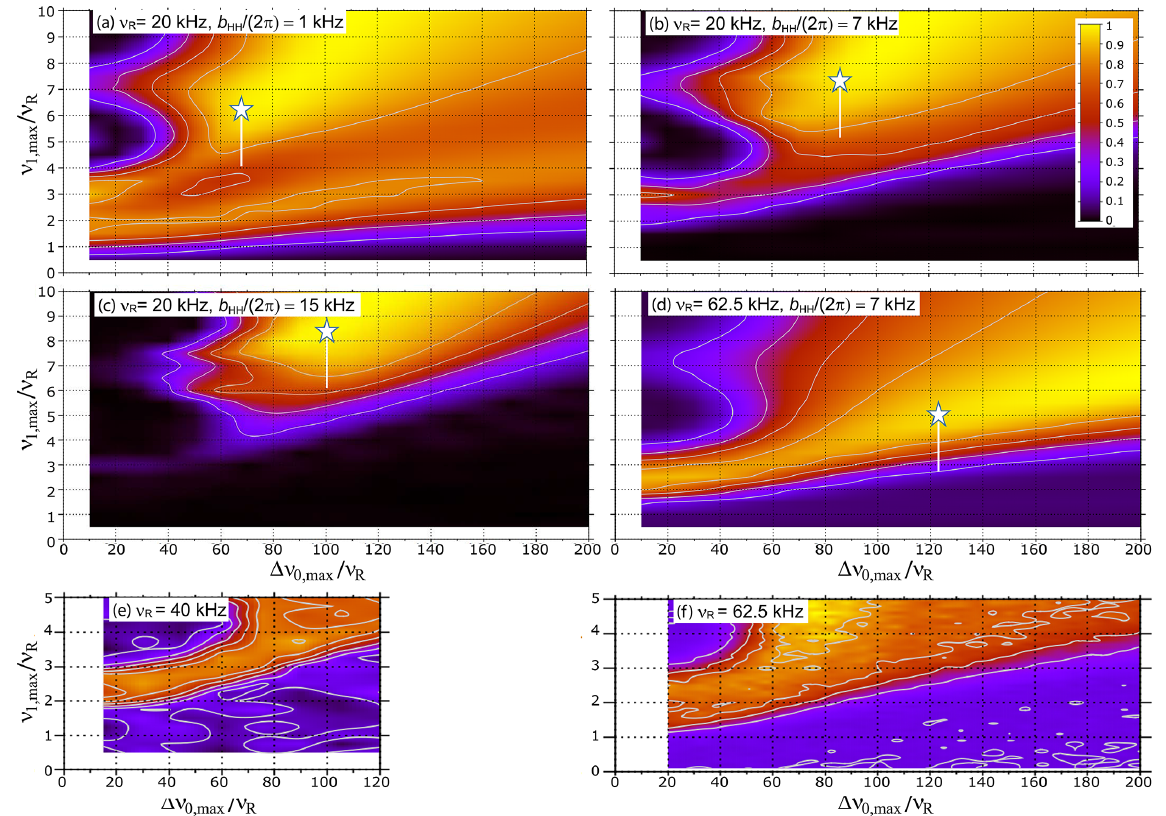
(tt) sequence for a 15 N 1 H 4 spin system as a function of Figure 2. (a–d) Simulated transfer efficiency of 1 H → 15 N D -RINEPT-SR4 2 1 ν 1 , max /ν R and (cid:49)ν 0 , max /ν R for ν R = 20 and 62.5kHz and b HH / ( π ) = (a) 1kHz, (b, d) 7kHz and (c) 15kHz. (e, f) Experimental 1 H → 15 N D -RINEPT-SR4 2 (tt) signal of L-histidine · HCl as a function of ν 1 , max /ν R and (cid:49)ν 0 , max /ν R at 18.8T with ν R = (e) 40kHz or (f) 62.5kHz. 1 In panels (a) – (d) the white star indicates recoupling conditions with minimal rf field leading to maximal transfer efficiency, and the white vertical line mimics the rf field distribution within the